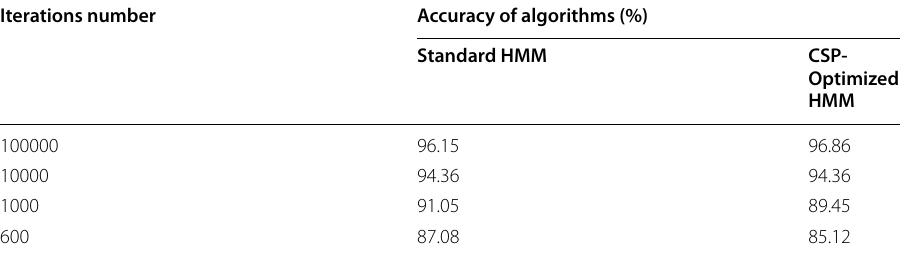
Table 6 Accuracy comparison